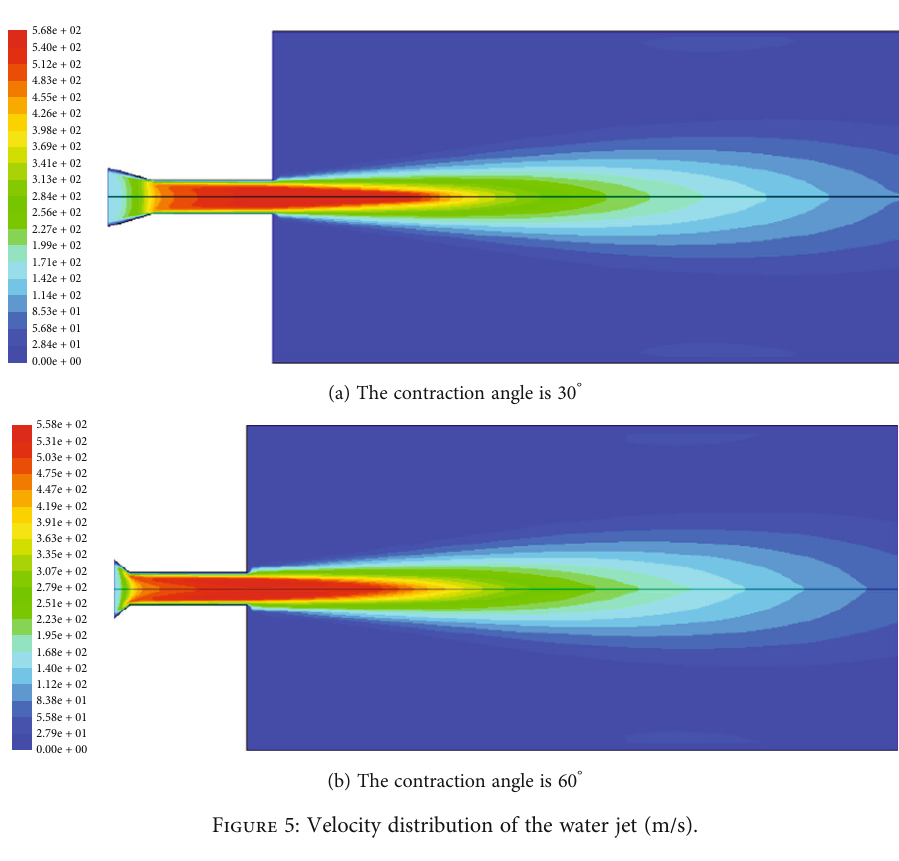
Figure 5: Velocity distribution of the water jet (m/s).